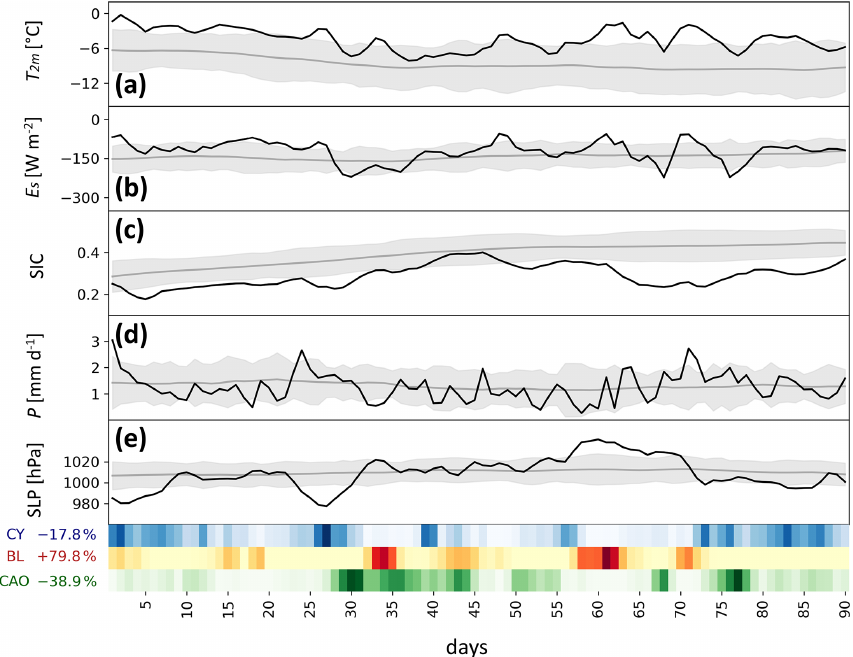
Figure 9. Time series of daily-mean (a) T 2m (in ◦ C), (b) E S (in Wm − 2 ), (c) SIC, (d) P (in mmd − 1 ) and (e) sea level pressure (SLP, in hPa) averaged in the region of the Kara and Barents seas (KBI, KBM and KBS) in DJF 2011/12 (black lines). The transient climatology is shown by grey lines. Grey shading shows the standard deviation of daily-mean anomalies in all winter seasons relative to the respective transient climatology. Blue, orange and green heat maps at the bottom of the figure show the daily-mean coverage of the region by cyclones, blocks and CAOs, respectively (the darker the color the higher the coverage). Relative frequency anomalies of the three weather systems are given in percentages. The horizontal axis indicates days since the start of the season with day 1 corresponding to 1